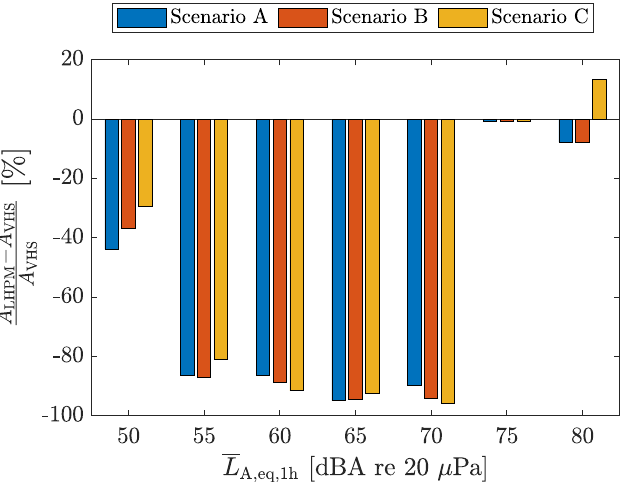
Figure 8. Relative L A,eq,1h isocontour area differences for the linear hold point merge procedure with respect to the vertical holding stack